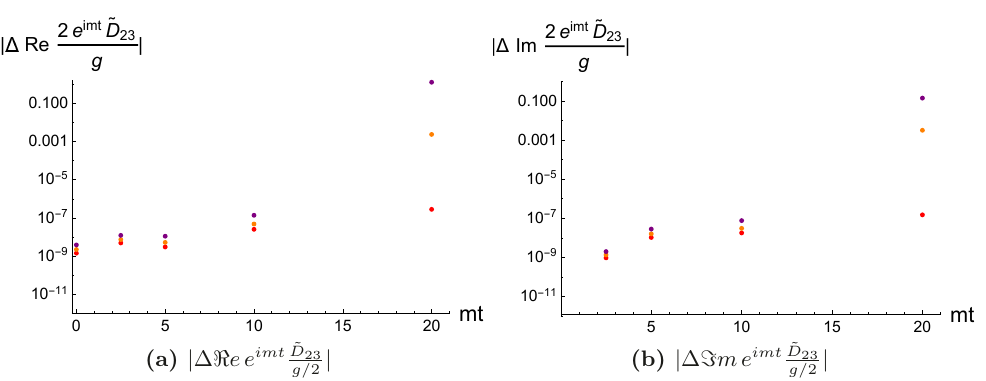
for different system g/ 2 40, 40 50 and 50 60 in − − −